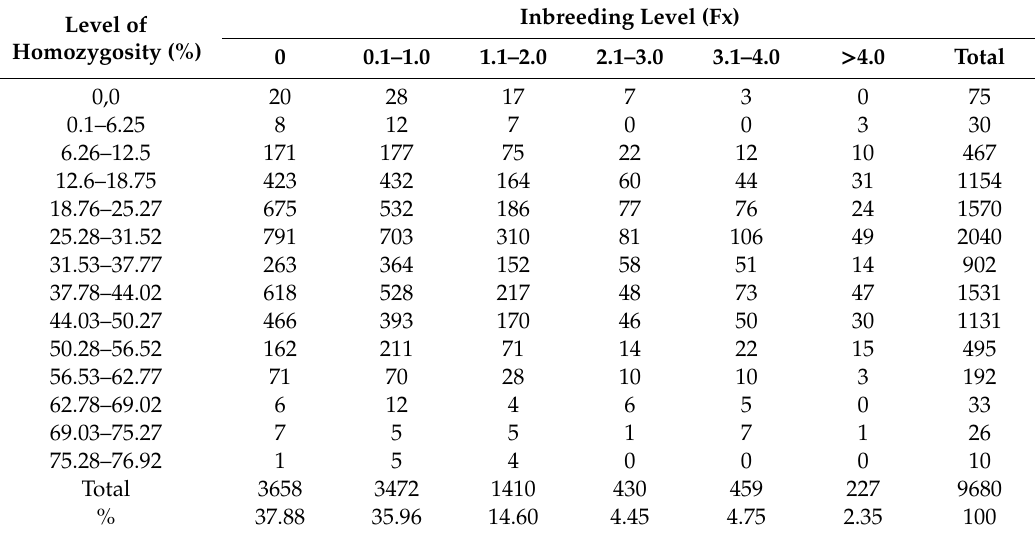
Table 5. The distribution of TB horses by the degree of homozygosity and the level of inbreeding (Fx). Level of